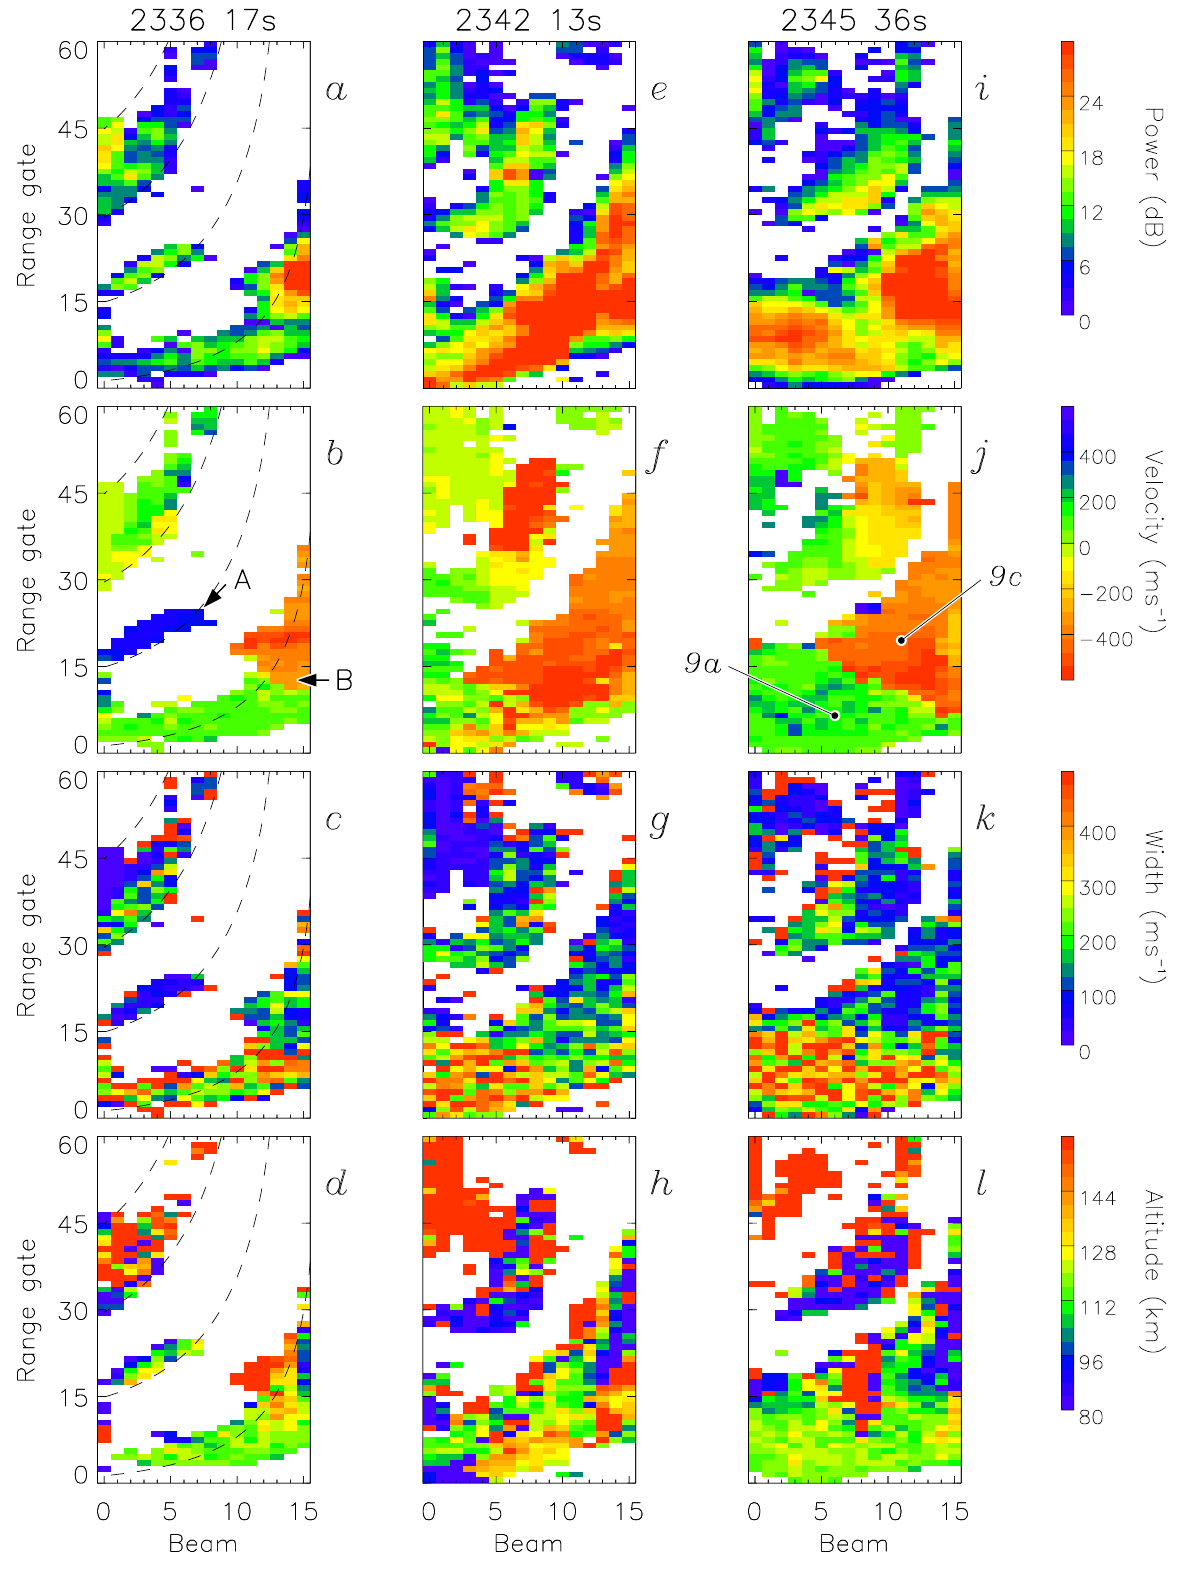
Fig. 4. Backscatter power, line-of-sight Doppler shift, spectral width, and estimated altitude of backscatter for scans starting 2336.17, 2342.13 and 2345.36 UT, illustrated in a rectilinear beam and range gate format. The radar cells for which the spectra are presented in Fig. 9a and c are indicated in panel j. Dashed lines in the first four panels indicate contours of constant geomagnetic latitude at 66 ◦ , 68 ◦ , 70 ◦ , and 72 ◦